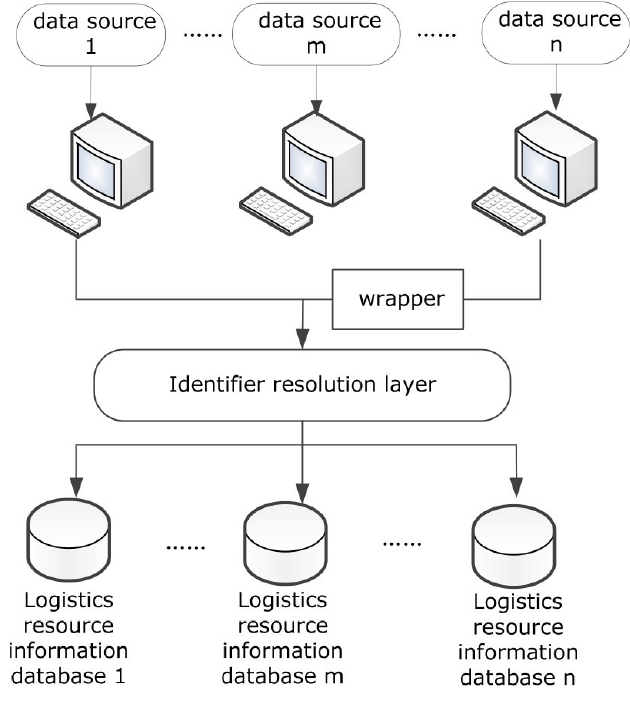
Figure 3. Network Topology of IRL